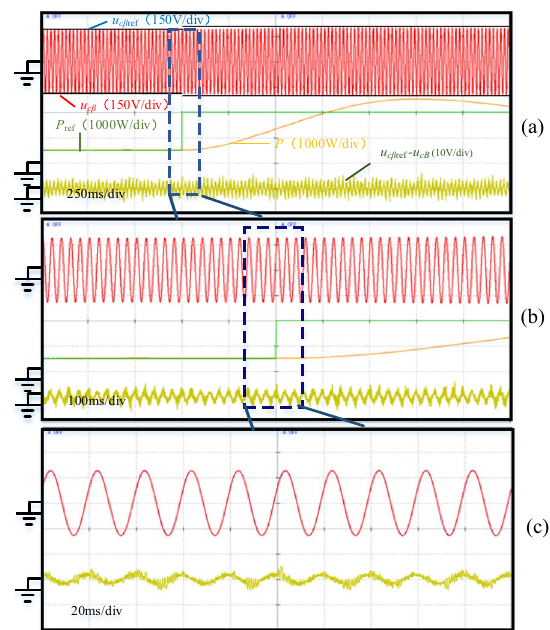
Fig. 9 Experimental waveforms during sudden change of active power without error compensation. a 250 ms/div. b 100 ms/div. c